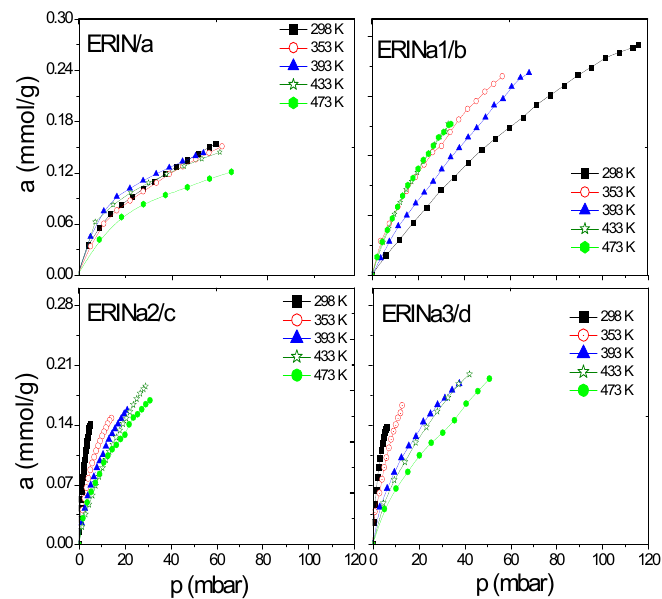
Figure 6. CH 4 adsorption isotherms at different temperatures on: ( a ) ERIN, ( b – d ) Na1–3 exchanged zeolites.